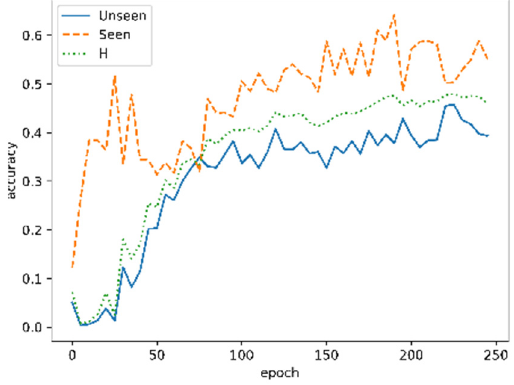
Figure 15. Accuracy of MVRFFNet on the fine-grained recognition dataset.